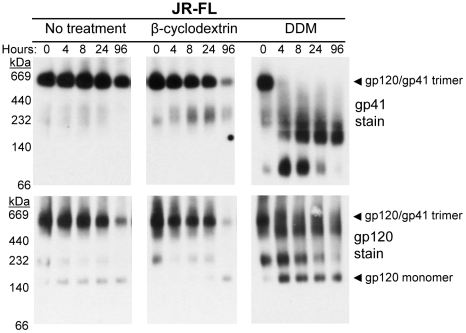
Time course dissociation of HIV-1 Env trimers in the presence of membrane altering reagents visualized using BN-PAGE.HIV-1LAI-JR-FL MC, produced in 293T cells, was incubated for 0 h, 4 h, 8 h, 24 h, or 96 h at 37°C in the presence of no compound (left), 70 mM β-cyclodextrin (cholesterol scavenger; center), or 1% DDM (mild detergent; right). Following incubation for the indicated time periods, samples were analyzed by BN-PAGE and Western blot as in
Fig. 4
.